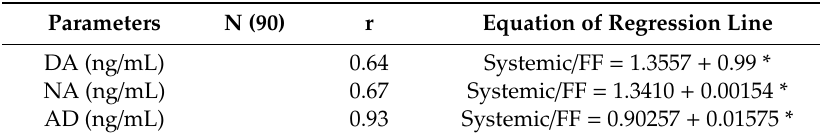
Table 1. Systemic and intrafollicular dopamine (DA), noradrenaline (NA) and adrenaline (AD) correlation coe ffi cients in follicles of mares. Results are presented as mean ± SD; * p <